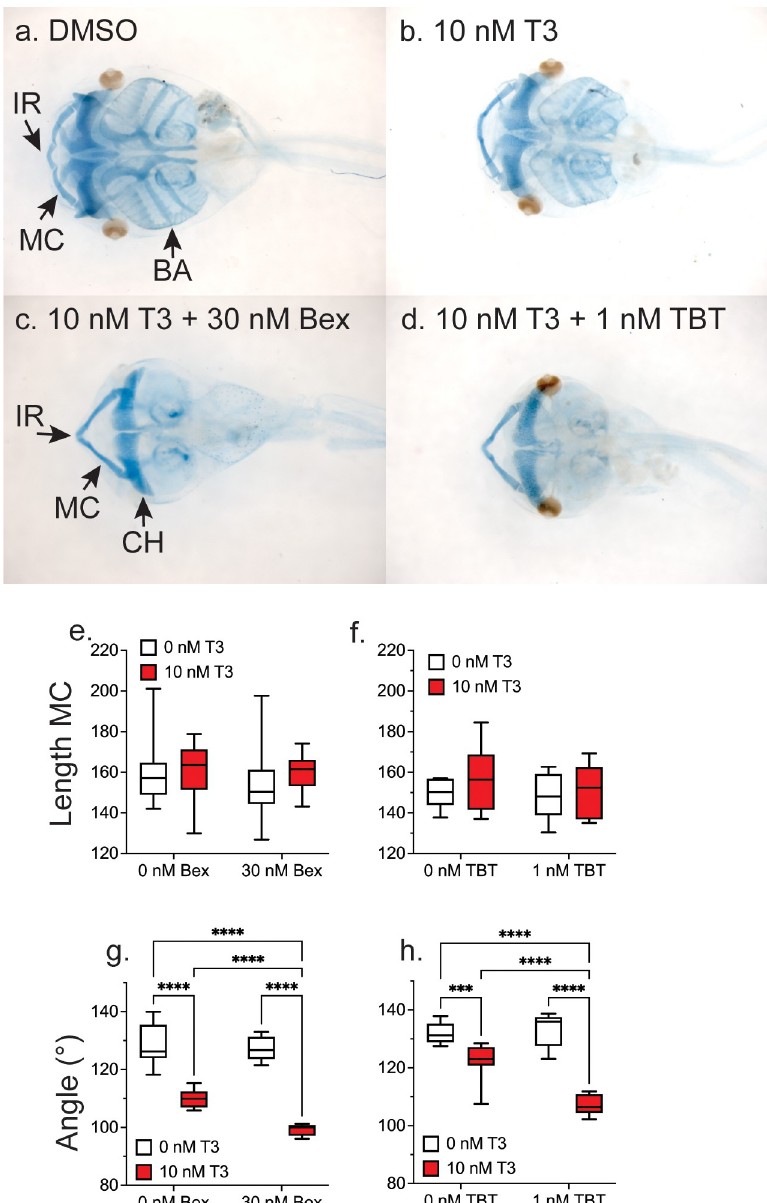
Fig 2. RXR agonists potentiate T3-induced remodeling of LJ cartilage and resorption of gill cartilage. Representative ventral head photos of tadpoles treated for five days starting at 1wk-PF with vehicle (DMSO, a), 10 nM T3 (b), 10 nM T3 + 30 nM Bex (c), or 10 nM T3 + 1 nM TBT (d) and then stained with Alcian blue to visualize cartilage. MC, Meckel’s cartilage; IR, infracostal cartilage; CH, ceratohyal cartilage; and BA, branchial arches. e-f: Meckel’s cartilage lengths do not change with treatment. g-h: Changes in LJ angle measured from the end of the MC to the middle of the IR to the end of the opposite MC. Box plots are as in Fig 1 (n = 10 from 2 clutches of five per treatment. Statistics show results from Sidak’s multiple comparison test in conjunction with 2-way ANOVA ( ���� , p < 0.0001; ��� , p < 0.001). treated for four days instead of five to facilitate LJ removal; T3-induced changes to the overall head structure make removing the LJ more difficult after five days of treatment. Proliferative cells were counted from blinded images over the area of MC-IR (Fig 3A). Fig 3B–3F show